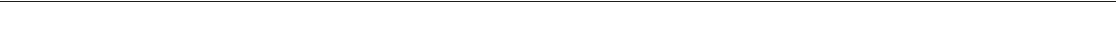
Fig. 5 Nestin protects lamin A/C from proteasomal degradation. a , b Half-life analysis of lamin A/C in control and Nestin-knockdown A549 cells. All groups of A549 cells were treated with cycloheximide (50 μ g/ml), harvested at the indicated times, and subjected to immunoblotting ( a ). Quanti fi cation of lamin A/C levels relative to β -actin is shown ( b ). c , d Identi fi cation of the pathway responsible for lamin A/C degradation upon Nestin knockdown. Control and Nestin-knockdown A549 cells were treated with Z-VEID-FMK (20 μ M, 2 h), 3-MA (5 mM, 2 h) ( c ), or MG132 (20 μ M, 6 h) ( d ), and then proteins were extracted and subjected to immunoblotting. e , f The effects of Nestin knockdown on ubiquitination of lamin A/C were analyzed by in vivo ubiquitination assays. Control and Nestin-knockdown A549 cells were treated with MG132 (20 μ M) for 6 h before harvest. Lamin A/C was immunoprecipitated with anti-lamin A/C antibody and immunoblotted with anti-Ub antibody ( e ) or anti-lamin A/C antibody ( f ). g , h Immunoblotting and immunostaining analysis of lamin A/C distribution in nucleus and cytoplasm. Control and Nestin-knockdown A549 cells were treated with MG132 (20 μ M, 2 h) and then treated with or without 25 ng/ml LMB. After 4 h, the cells were fractionated for immunoblotting analysis (C cytoplasmic cell lysates, N nuclear cell lysates) ( g ) or stained with anti-lamin A/C antibody (green) and anti-Nestin antibody (white). Scale bars, 20 μ m ( h ). i The effects of Nestin knockdown on ubiquitination of cytoplasmic lamin A/C were analyzed by in vivo ubiquitination assays. Control and Nestin-knockdown A549 cells were treated with MG132 (20 μ M) for 6 h, harvested, and fractionated, and the cytoplasmic or nuclear lamin A/C fractions were immunoprecipitated and immunoblotted with anti-lamin A/C antibody. The quanti fi ed results were presented as mean ± SEM of three independent experiments, as assessed using two-way ANOVA test. ** P <